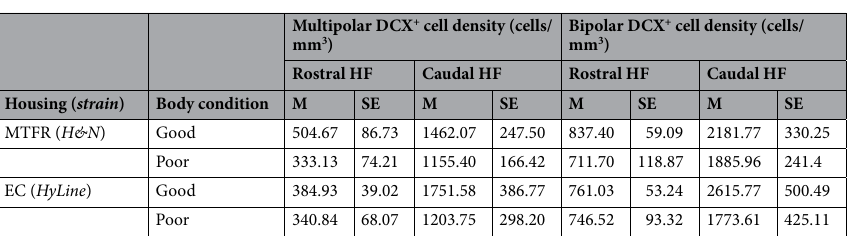
Table 6. Mean (M) and standard error (SE) for estimated densities of doublecortin (DCX) + cells with multipolar and bipolar morphologies in the rostral and caudal hippocampal formation (HF) of adult laying hens, grouped according to housing system (multi-tier free range (MTFR) versus enriched cage (EC)) and physical body condition (good/poor BC). n = 12 for each